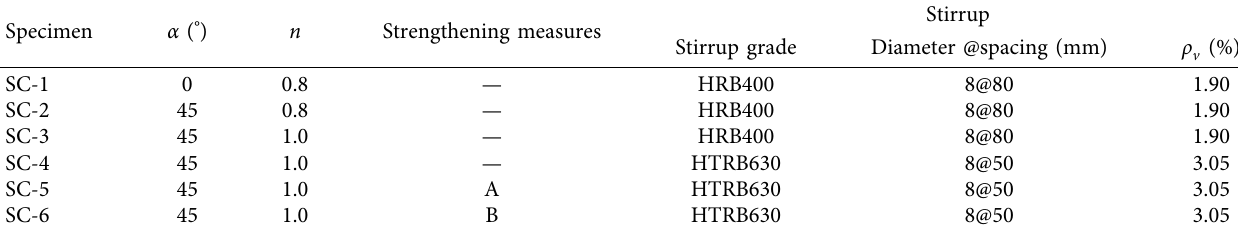
Table 1: Design parameters of specimens.